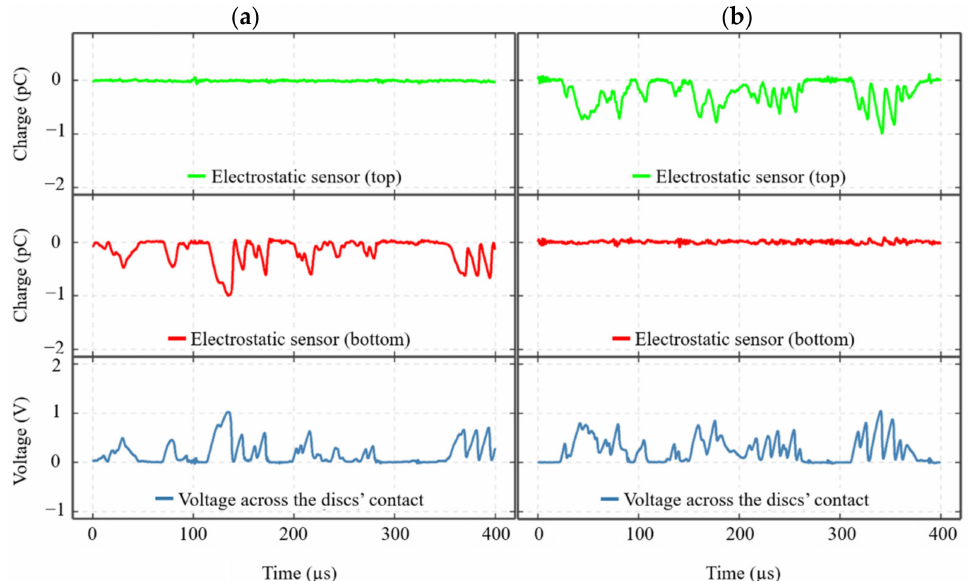
Figure 12. Discharging events detected by ES sensors and voltage measurement across the contact, from two tests conducted at a rotational speed of 3000 rpm, a load of 1145 N and lubricant inlet temperature of 40 ◦ C whilst the supply voltage was varied. The data shown in the graphs were captured when the supply voltage was at 10 V. ( a ) The current flowed from the bottom-to-top disc, and ( b ) from the top-to-bottom disc.